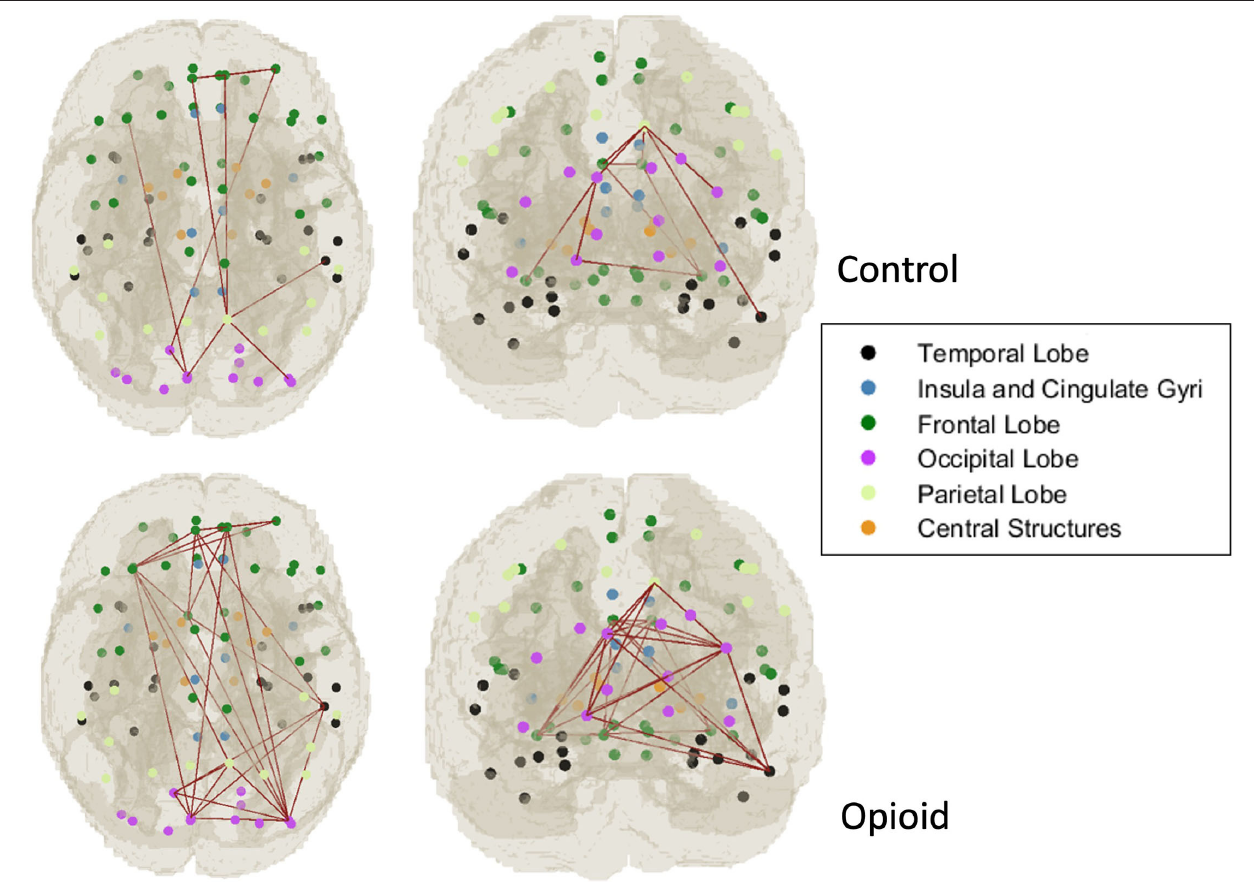
FIGURE 2 | Graph network modeling representation. Representative example of single subject graph network modeling for CAP C6 network in a control infant (top row) and infant with POE (bottom row). The dots refer to the center of the atlas region of interest and the connecting lines represent the thresholded graph network connections in these